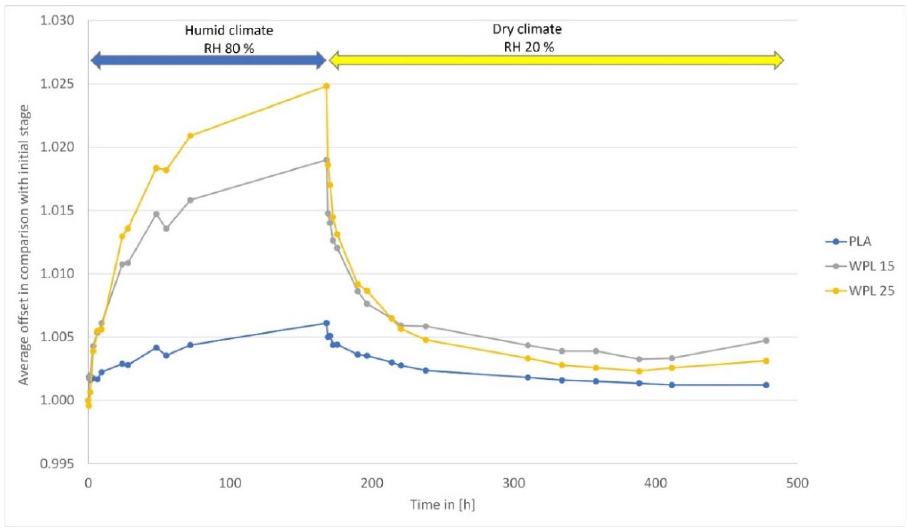
Figure 2. Adsorption and desorption curve of PLA, WPL 15, and WPL 25